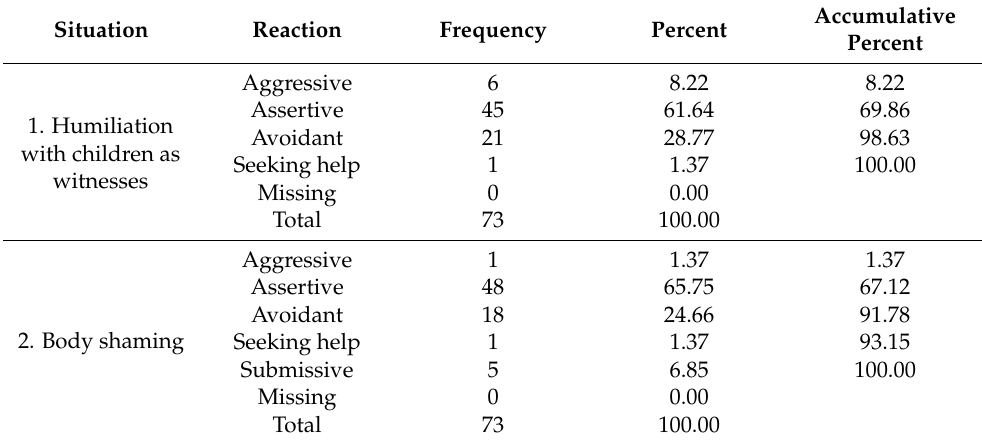
Table 1. Frequencies for reactions facing simulated situations of psychological